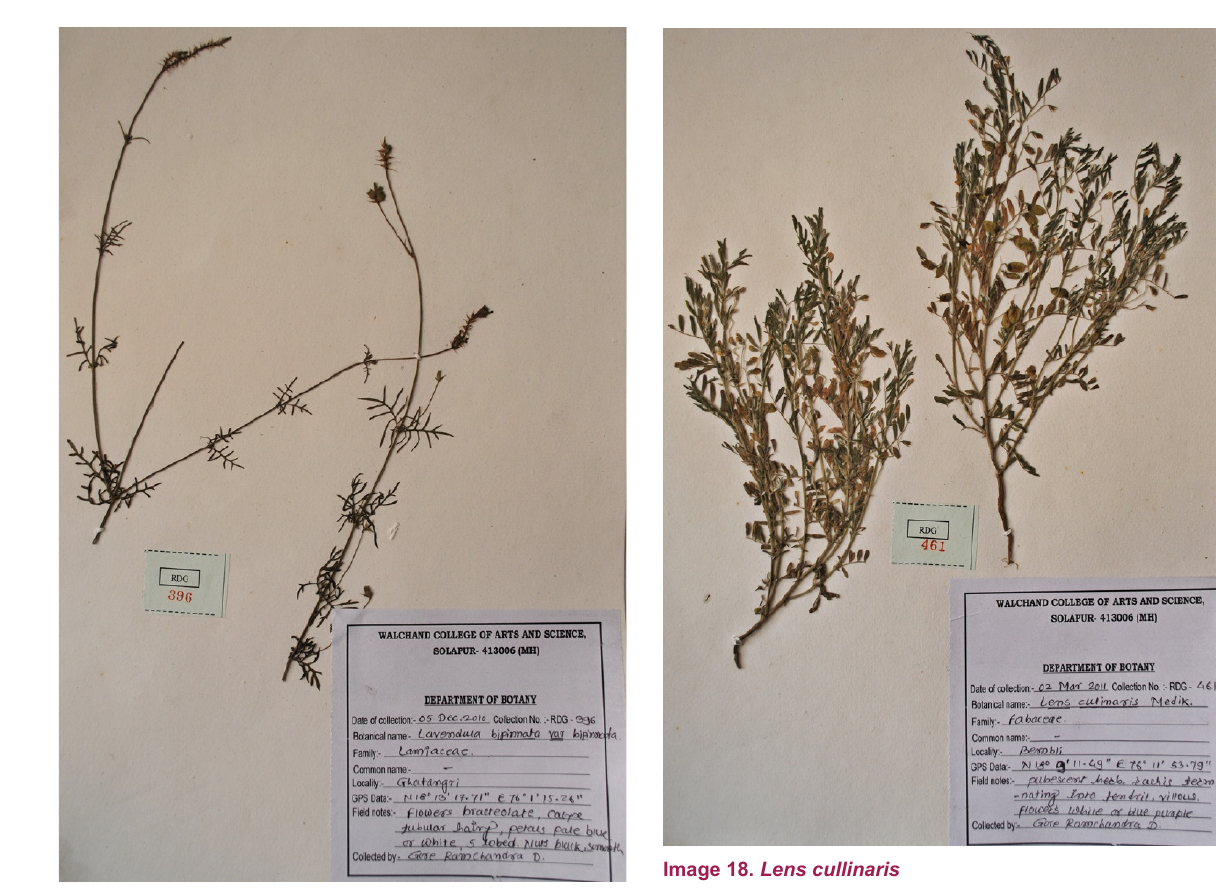
Image 17. Lavendula bipinnata var. bipinnata